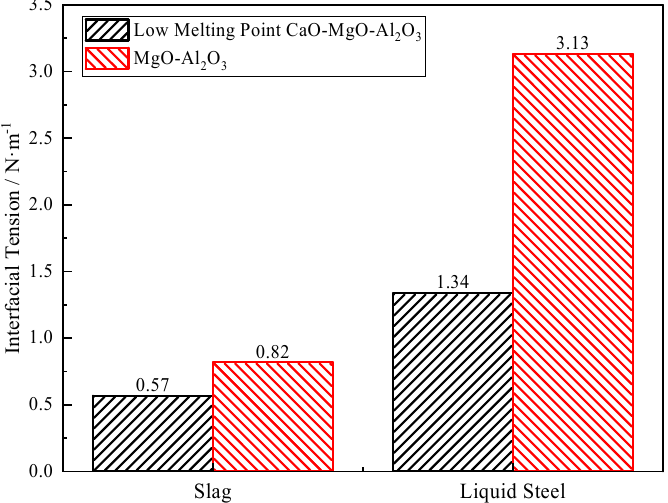
Figure 13. The velocity and resultant force changes of the low-melting-point CaO-MgO-Al 2 O 3 inclusions.